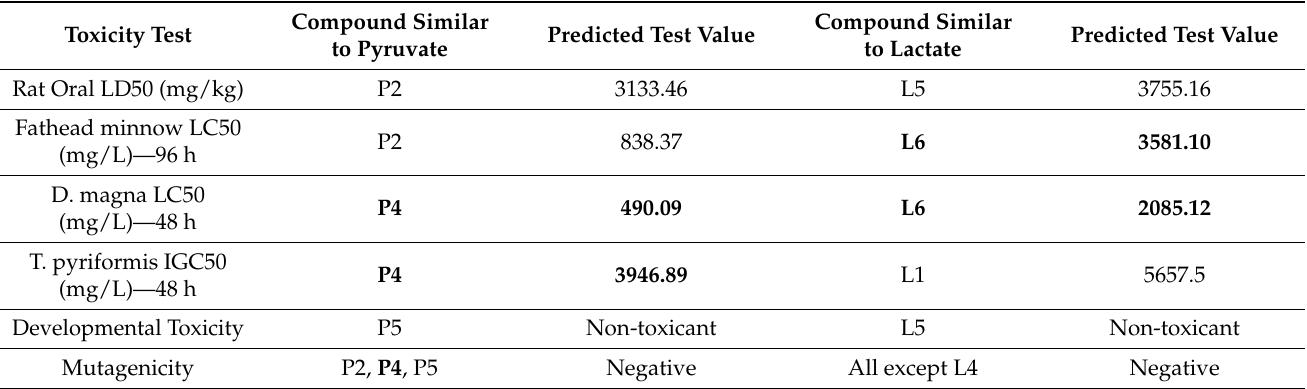
Table 3. Estimated toxicity values for compounds that were selected in QSAR structure-based drug design. Highest toxicity values are presented for all the compounds. The compounds that were selected for inhibition analyses are highlighted in